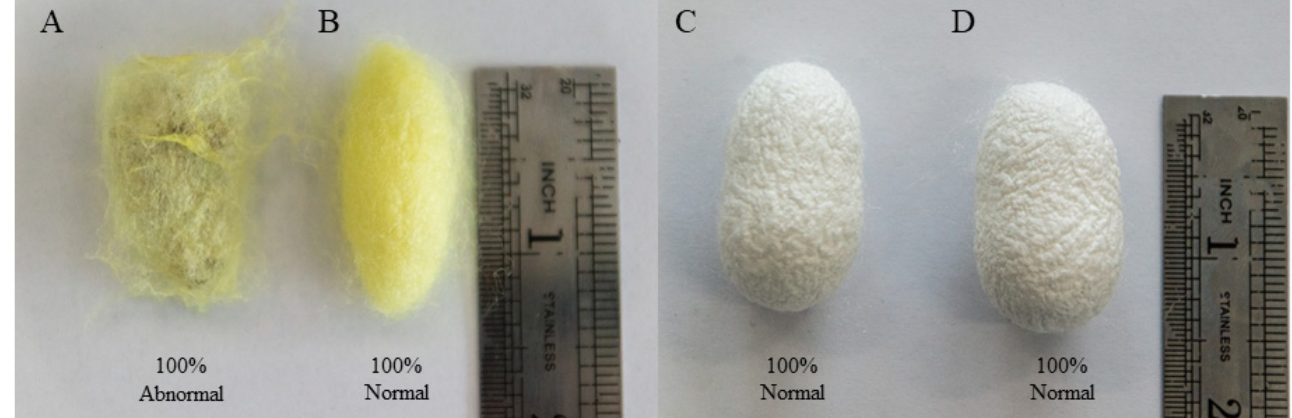
Figure 1. Phenotype of different resistant strains after AcMNPV inoculation. ( A ) p50 was infected with AcMNPV, ( B ) p50 without treatment, ( C ) C108 was infected with AcMNPV, and ( D ) C108 without treatment.